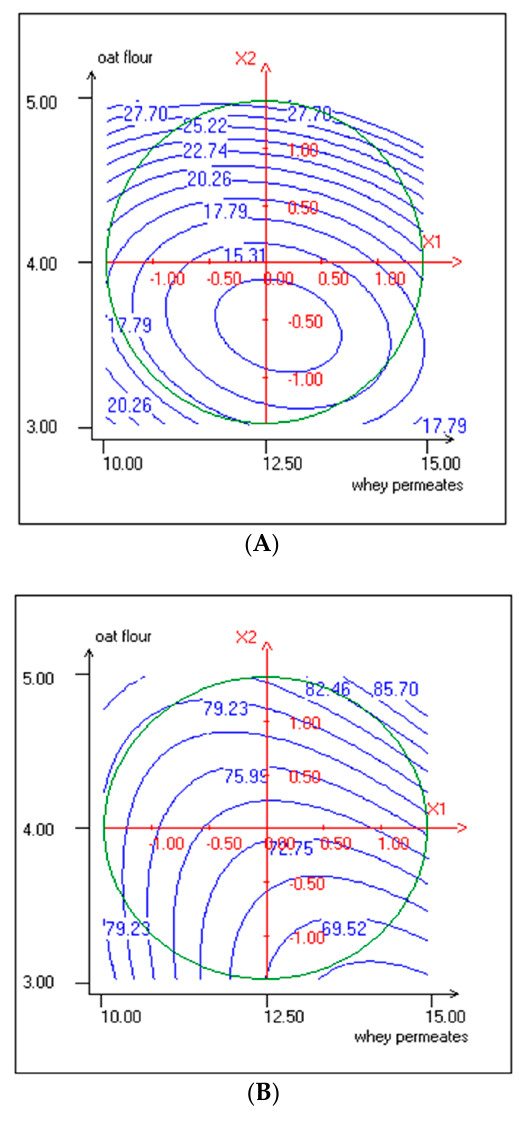
Figure 3. ( A ) Response surface and contour plots representing the effect of WP and OF on total polyphenol content (X1: WP; X2: OF). ( B ) Response surface and contour plots representing the effect of WP and OF on DPPH radical scavenging activity (%) (X1: WP; X2: OF).